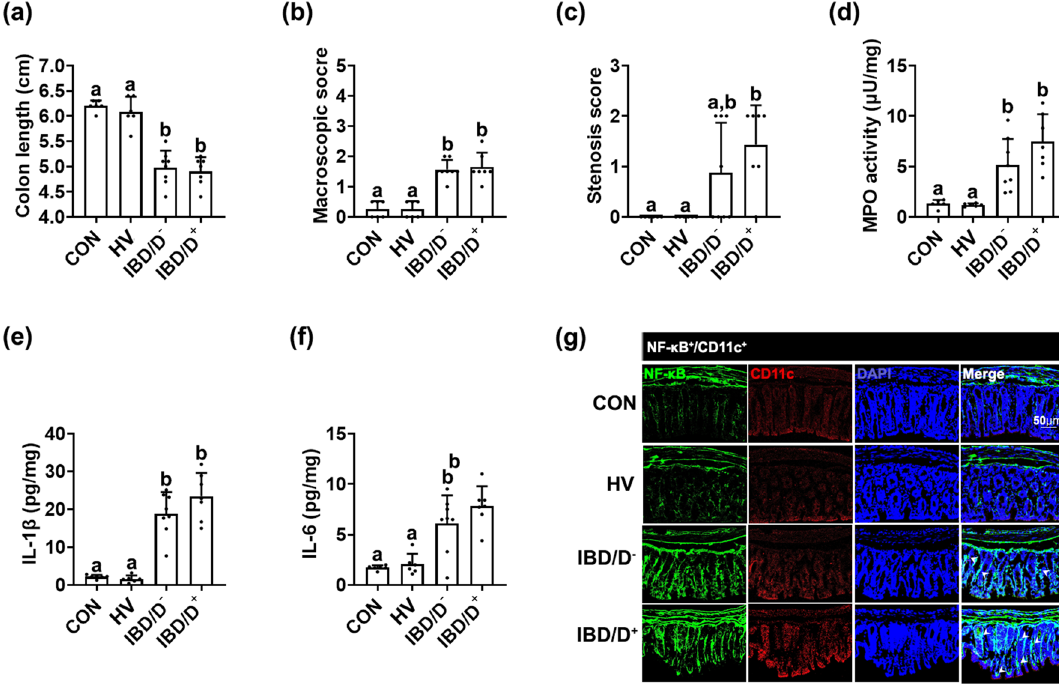
Figure 1. Fecal microbiota transplantation from patients with IBD/D + or IBD/D − and healthy volunteers (HVs) caused colitis in the transplanted mice. Effects on the colon length ( a ), macroscopic score ( b ), stenosis score ( c ), myeloperoxidase activity ( d ), IL-1β ( e ) and IL-6 expression ( f ), and NF-κB + /Iba1 + cell population ( g ) in the colon. Each HV-F (n = 6), IBD/D − -F (n = 8), or IBD/D + -F (n = 7) was orally transplanted in three mice once from 3 mice). Means with same letters are not significantly different ( p < 0.05). All data were analyzed using ANOVA with Tukey’s multiple comparisons